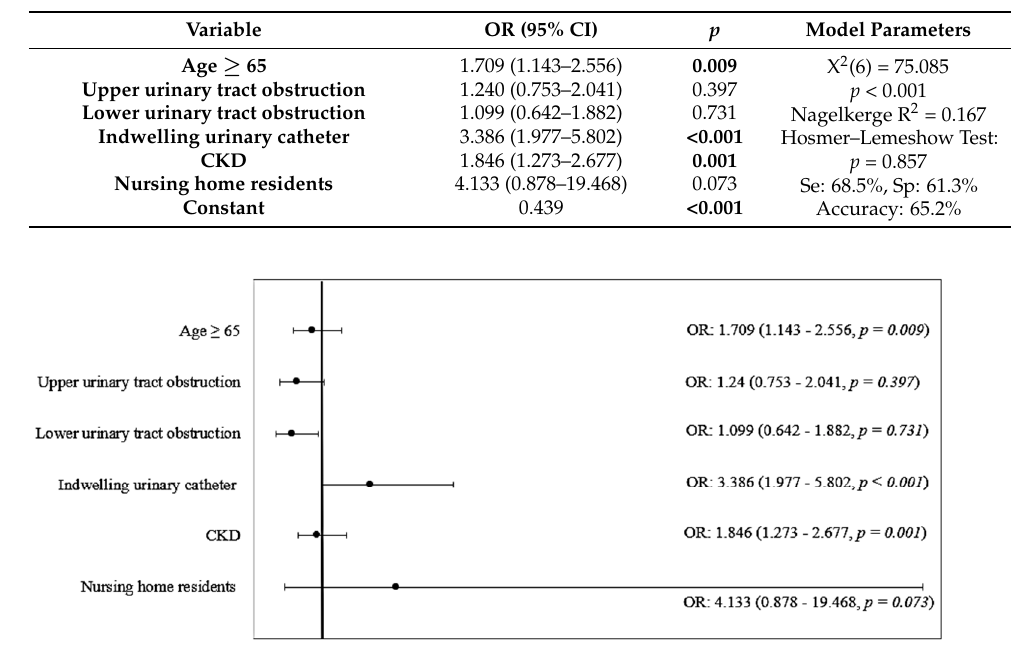
Figure 1. Forest plot for odds ratio with 95% confidence intervals univariate analysis of risk factors for general antibiotic resistance. Table 4. Multivariate logistic regression for general antimicrobial resistance prediction.